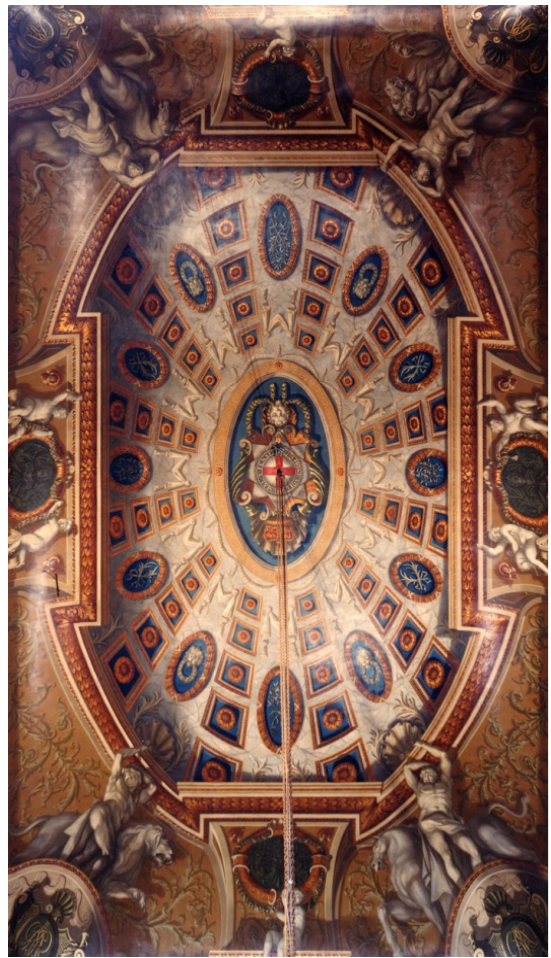
Figure 1. Rectified view of the painted ceiling over the Queen’s Staircase at Hampton Court